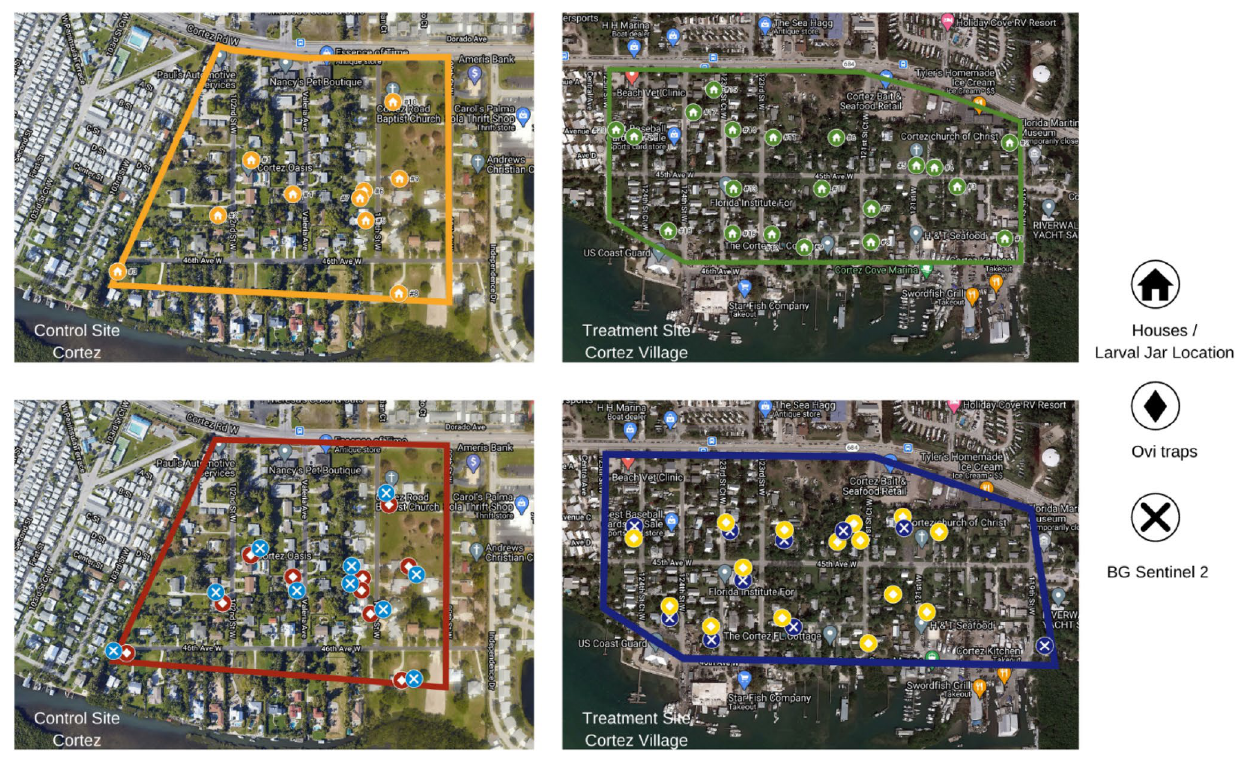
veillance locations with ovitraps and BG-Sentinel 2 Traps. Bottom Right: Treatment site surveillance locations with ovitraps and